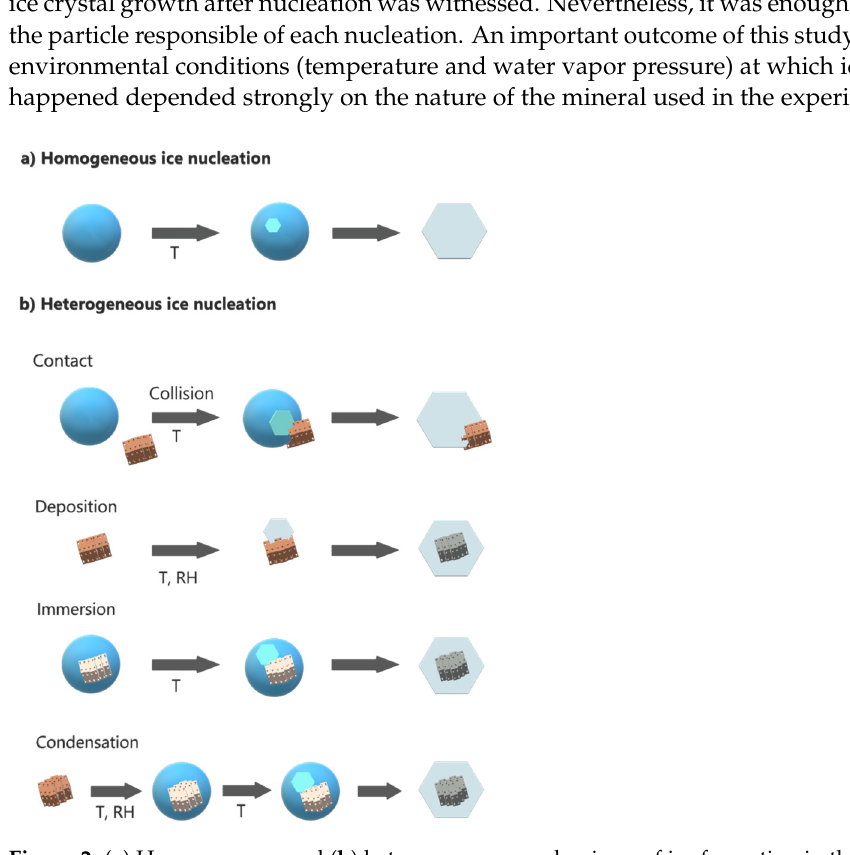
Figure 2. ( a ) Homogeneous and ( b ) heterogeneous mechanisms of ice formation in the troposphere.